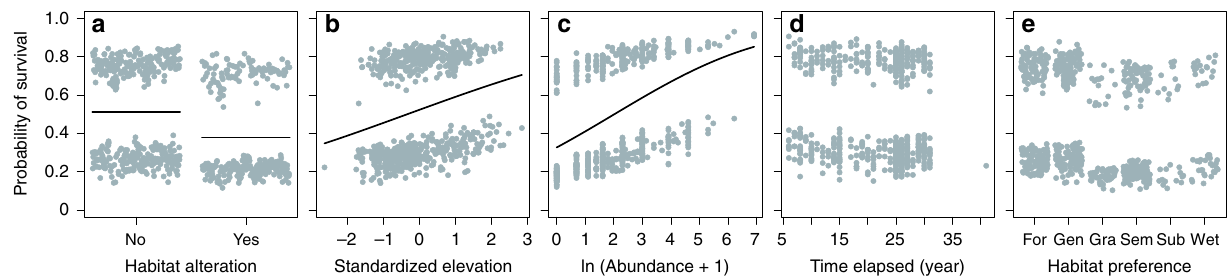
Fig. 4 Biotic and abiotic drivers of local population extirpation. Partial residual plots showing the effect of a habitat alteration, b elevation, and c population size on orchid probability of occurrence in resurveyed sites. Also non-signi fi cant effects of d time elapsed between the initial and second survey and e habitat preference were reported. Elevation was standardized to mean 0 and SD 1 to make elevational ranges comparable among species, i.e. the most negative values corresponded to the rear edge and the largest positive values to the leading edge. Plots were drawn using the visreg() function with default settings in the visreg package in at the upper limits, where population size showed a less pro- nounced decrease (Fig. 5a, c, e). Populations of generalist orchids decreased (Fig. 5b), and even if only with a marginal trend, their tion size of most species decreased in recent years, but with dif- decline was also stronger at the rear than at the leading edge ferences among habitat preference categories, and for some (Time × Elevation p = 0.066). This effect on population size is categories at different elevations (Fig. 5). In accordance with an consistent with the higher probability of extinction at the rear expected negative effect of warming at the rear edge 37 , population size at the lower elevational limits of forest (Time × Elevation p = edge observed in the resurveys (Fig. 4b). Population size did not 0.002), grassland (Time × Elevation p = 0.011) and subalpine change over time only for two groups with contrasting climate species (Time × Elevation p = 0.043) declined more strongly than and habitat preferences. Species associated with semi-natural